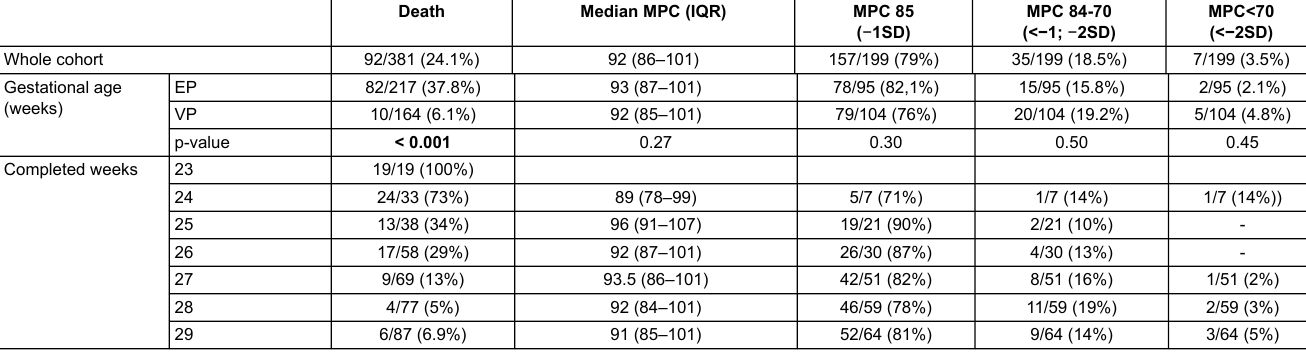
Table S1: Mortality and cognitive outcome at early school age according to gestational age.